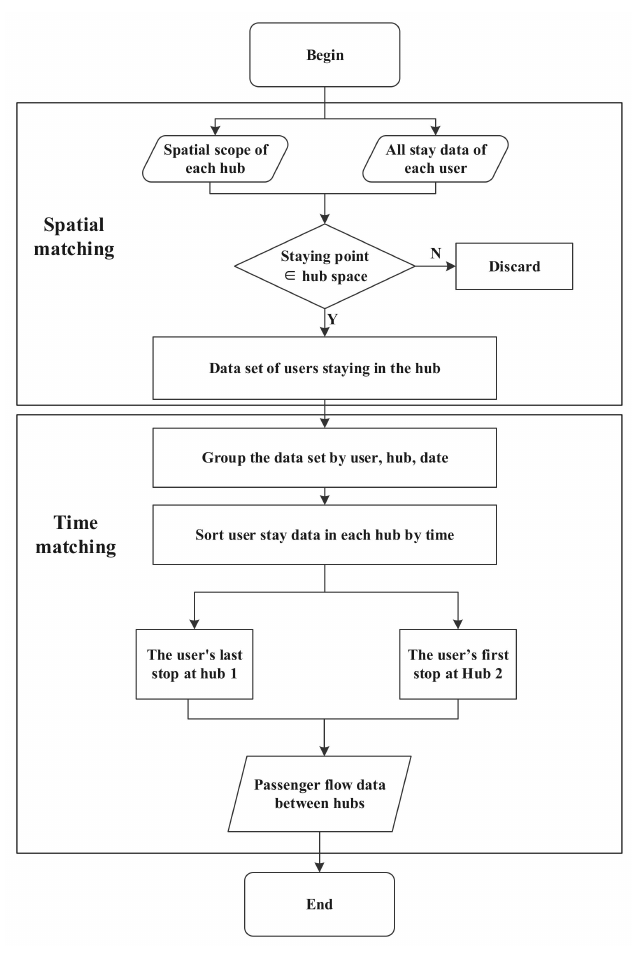
Figure 3. Extraction of intercity travel